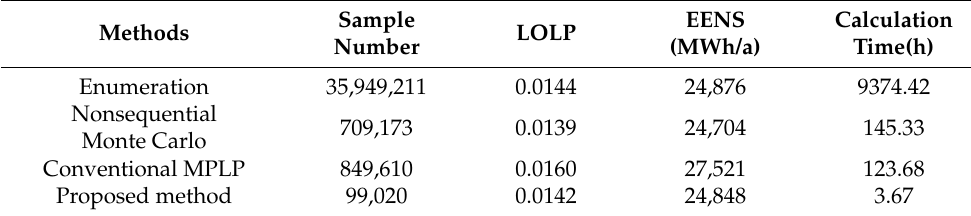
Table 3. Reliability assessment results of the IEEE-RTS 96 system.